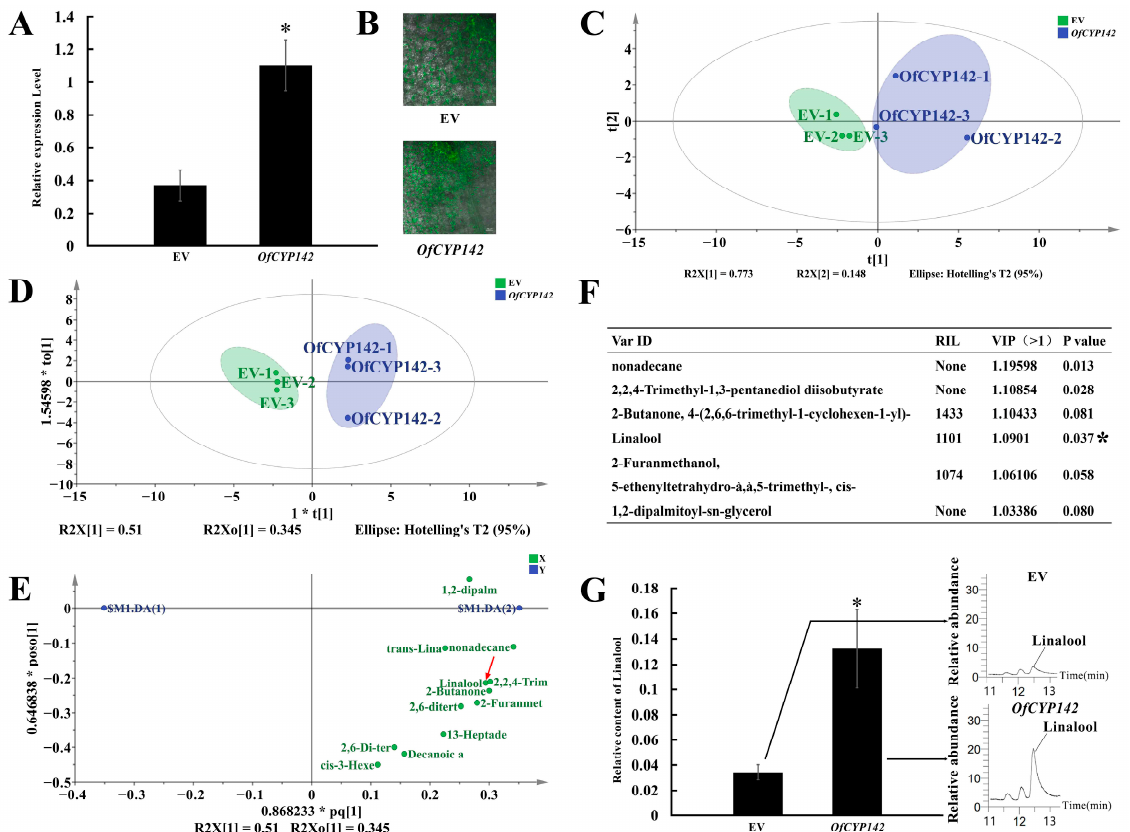
Figure 7. Functional characterization of OfCYP142 by transient expression. ( A ) qRT-PCR analysis of the OfCYP142 relative expression levels in control and transgenic O. fragrans flowers. ( B ) The GFP fluorescence of p35S:OfCYP142:GFP and empty vector fusion proteins. ( C ) Score scatter plot of the flower GC–MS profiles of two types of petals with transient expression of OfCYP142 and empty vector in O. fragrans , determined with PCA-X analysis in SIMCA14.1. Each type of petals consisted of three replicates. ( D ) Score scatter plot of the flower GC–MS profiles of two types of petals with transient expression of OfCYP142 and empty vector in O. fragrans , determined with OPLS-DA analysis in SIMCA14.1. ( E ) Loading scatter plot analysis of floral volatile organic compounds in petals after transient transformation with 35S: OfCYP142 :GFP and empty vectors. The red arrow marks the linalool. ( F ) Information of key aromatic components selected based on VIP from OPLS-DA (VIP > 1). ( G ) Relative content analysis of linalool after transient transformation with 35S: OfCYP142 :GFP and empty vectors. “*” represents significant difference at p < 0.05.